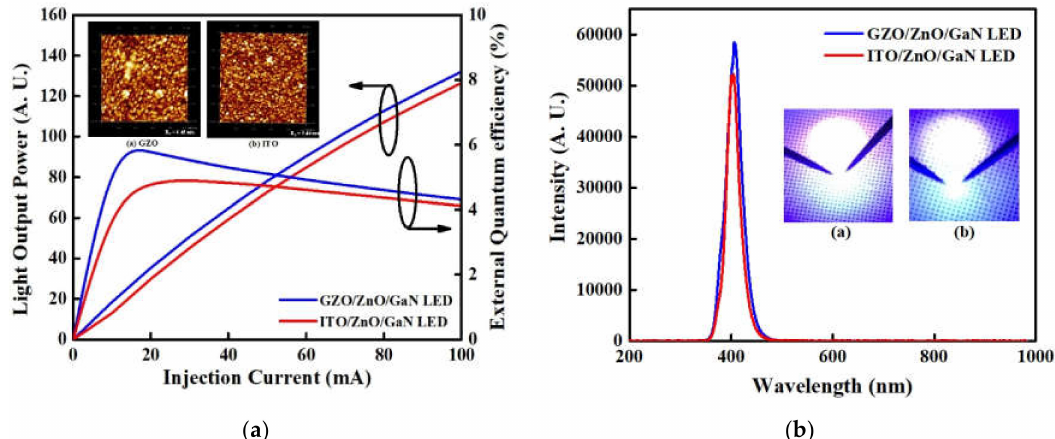
Figure 8. ( a ) Light output power and external quantum efficiency as a function of injection current and, ( b ) room-temperature EL spectra for n-ZnO/p-GaN LEDs with MIPEMOCVD-grown GZO and ITO window layers. The insets in ( a ) and ( b ) show the AFM images and micrographs of light emission for the n-ZnO/p-GaN LEDs with MIPEMOCVD-grown GZO and ITO window